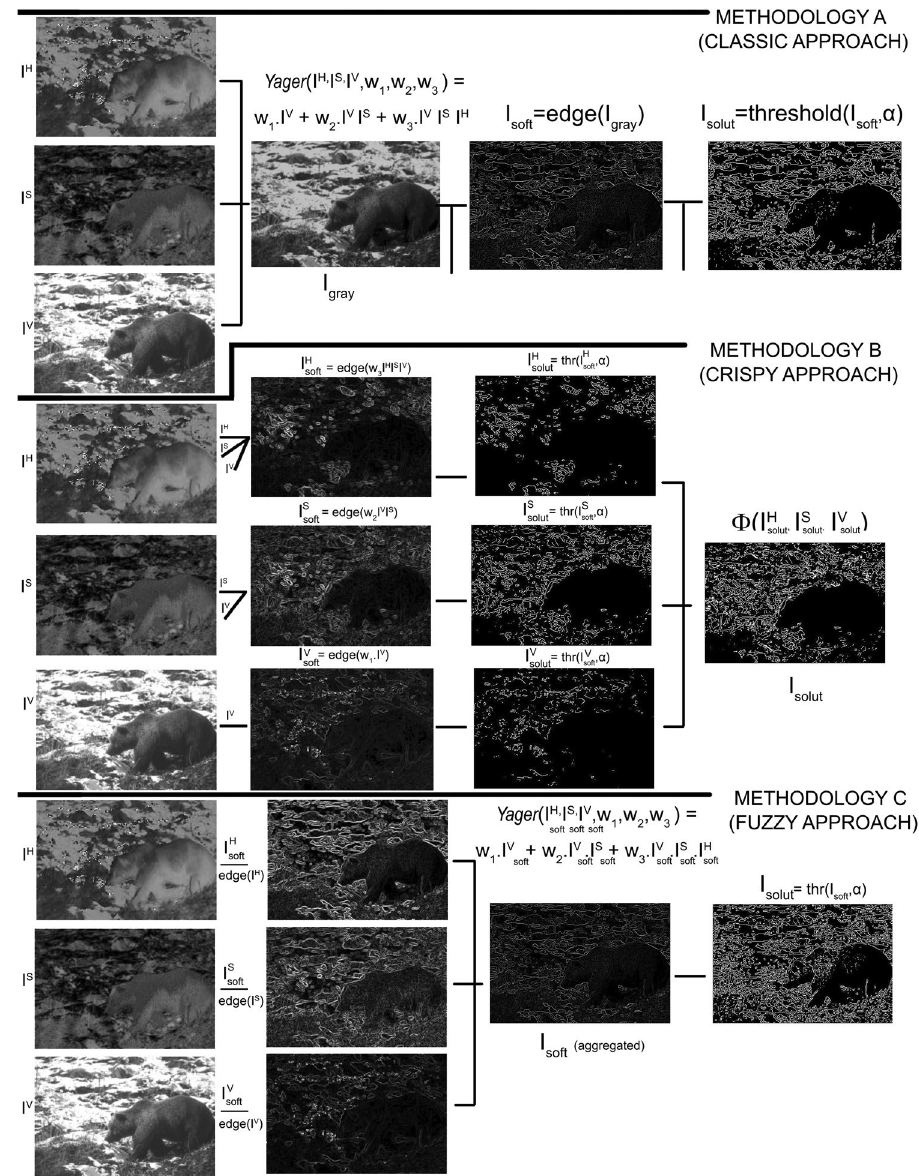
Fig. 3 Scheme of methods A, B and C with HSV